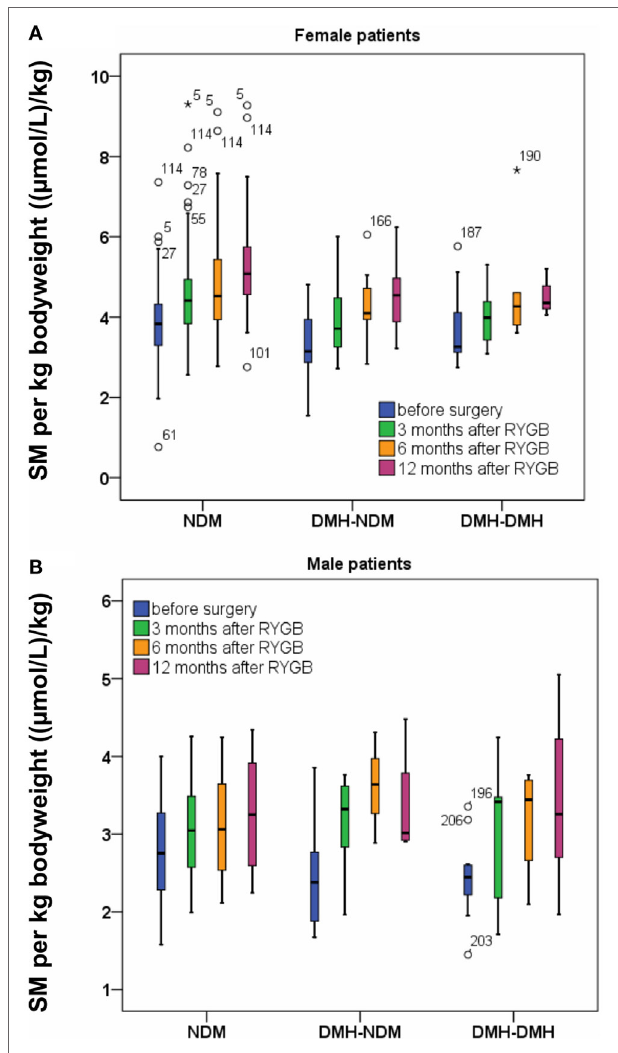
FigUre 3 | Sphingomyelin (SM) per kilogram bodyweight before and after Roux-en-Y gastric bypass (RYGB) surgery for female patients (a) and male patients (B) . Figure show boxes with median, 25 and 75% centiles before surgery and at 3, 6, and 12 months after